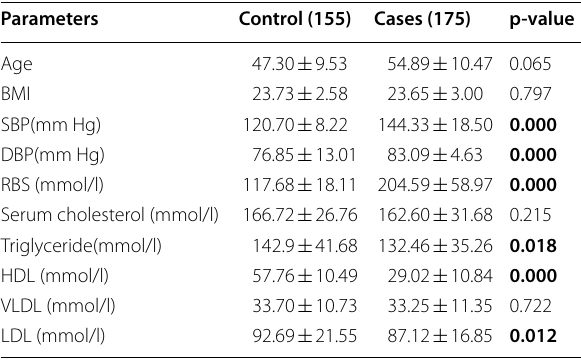
Table 1 Comparison of biochemical parameters in cases and controls